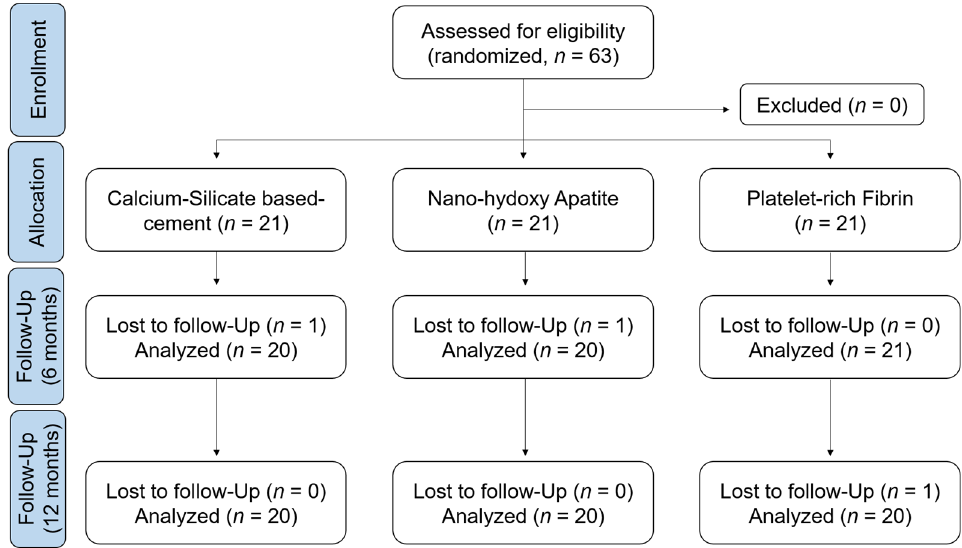
Figure 1. A CONSORT diagram showing the flow of participants through each stage of the study.